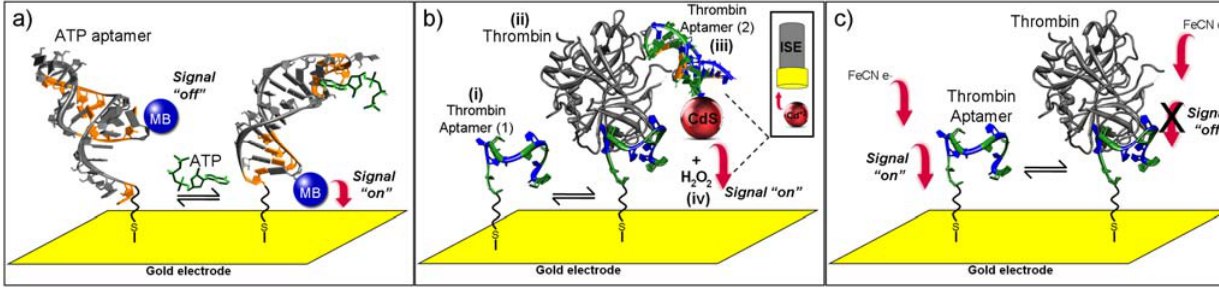
Figure 1. Typical aptasensor strategies for: ( a ) amperometric, ( b ) potentiometric or ( c ) impedimetric measurements. In panel (a), ATP binding aptamer labeled with methylene blue (MB) at one end was immobilized on gold surface at the other end. Specific interaction between aptamer sequence and ATP induces a conformational change, which significantly changes the electron transfer distance between MB and the gold surface. In panel (b), a primary thrombin binding aptamer is immobilized on gold surface via a